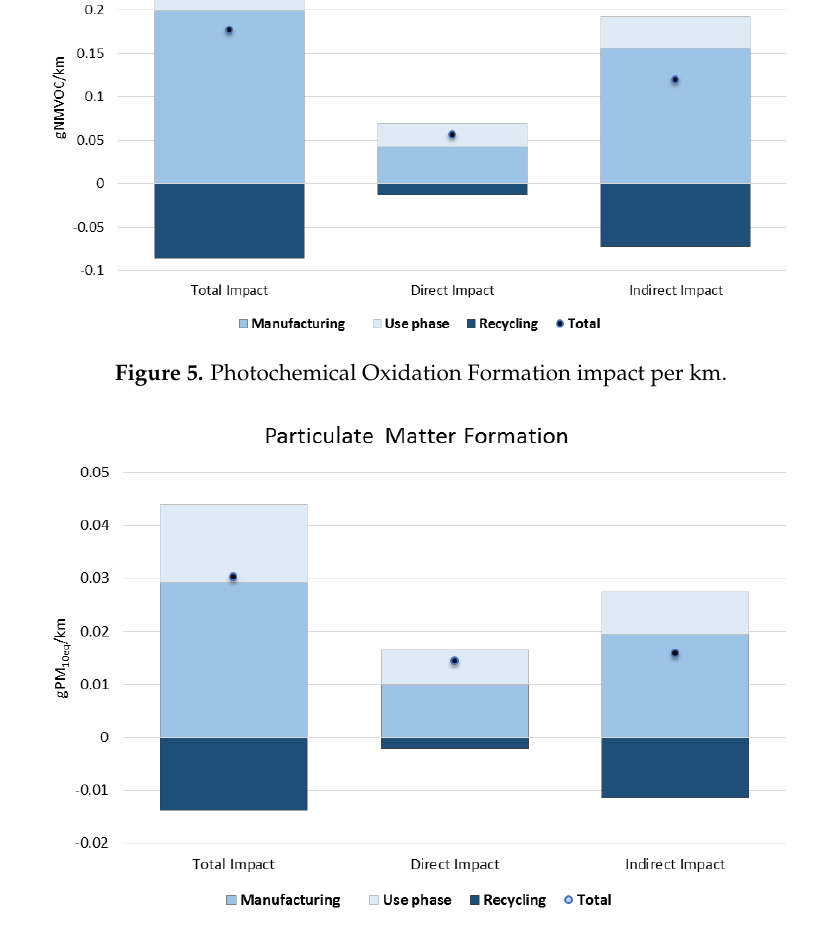
Figure 6. Particulate Matter Formation impact per km.